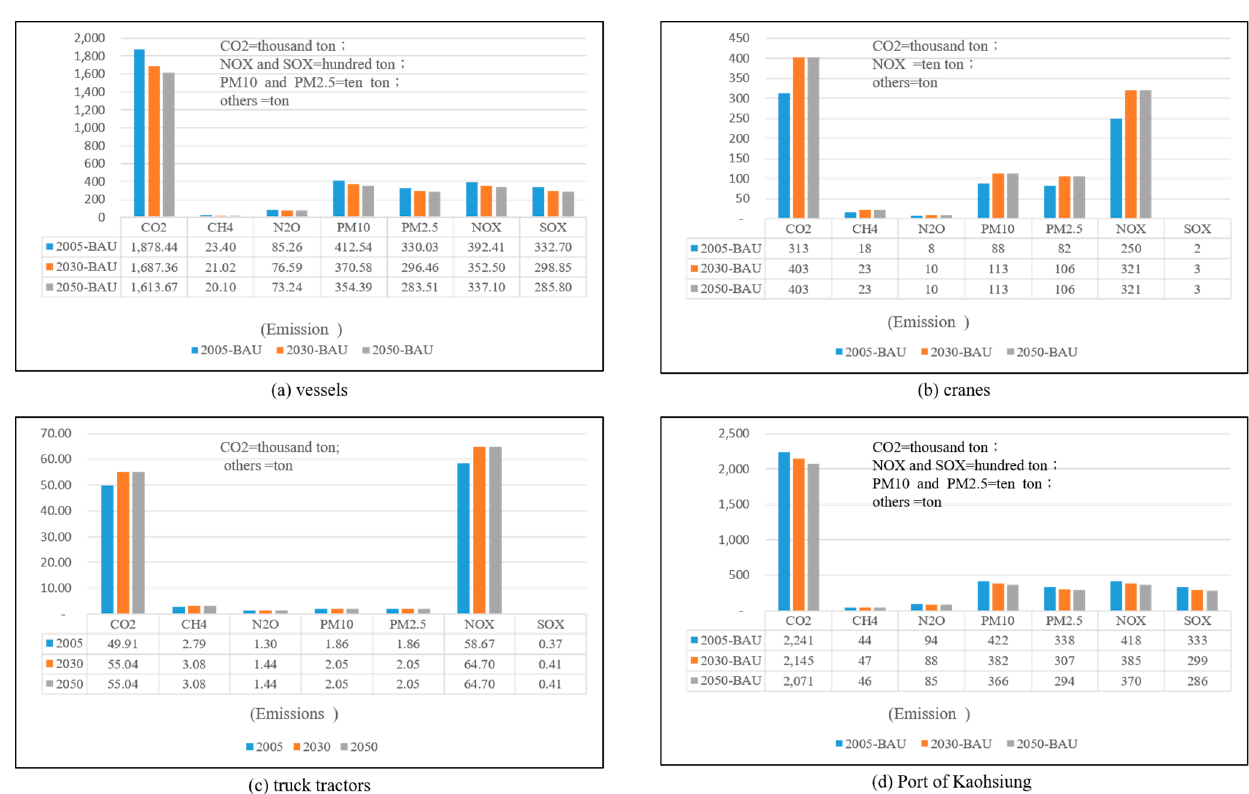
Figure 2. Emissions of vessels, cranes, truck tractors, and the Port of Kaohsiung in the BAU scenario.